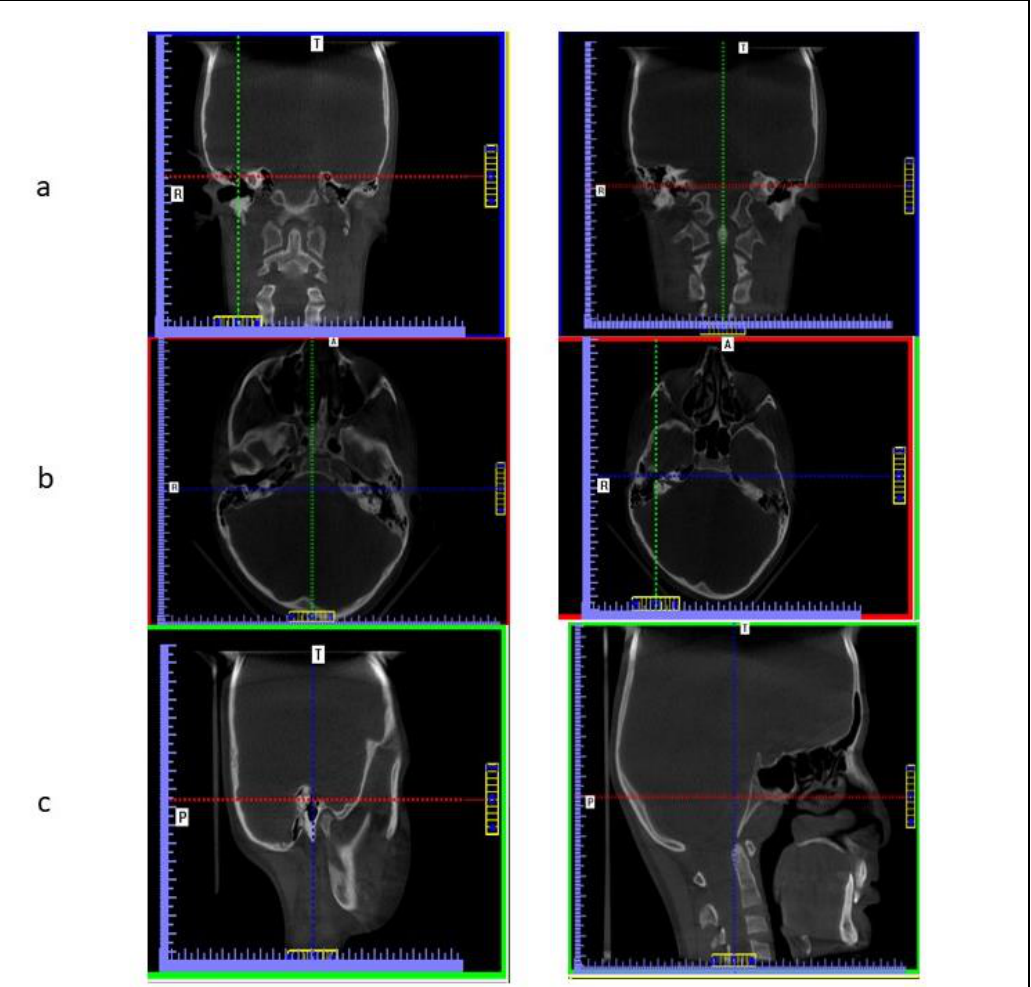
Figure 1. ( a ) Volume rotated mediolaterally until the transporionic line of the data became horizontal. ( b ) Volume rotated until the midsagittal plane of the data oriented vertically. ( c ) Sagittal view for which the Frankfort plane of the data was oriented horizontally. T is Transverse, A is Axial, R is Right side, P is Posterior Each of the images was imported into the nemoceph NX software (Visiodent, Saint-Denis, France) for linear measurements. The distance of the bilateral landmark was calculated from the midsagittal plane on the cleft and non-cleft sides for bothfrontal and axial views. The data obtained weresubjected to statistical